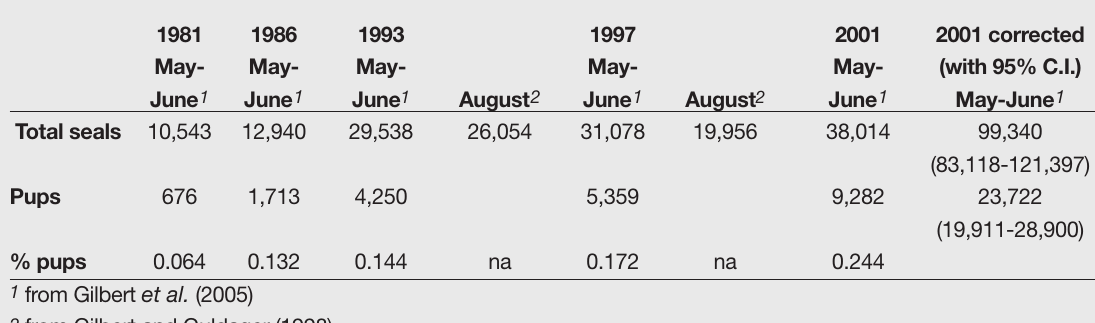
Table 2. Counts of harbour seals and pups from surveys along the Maine